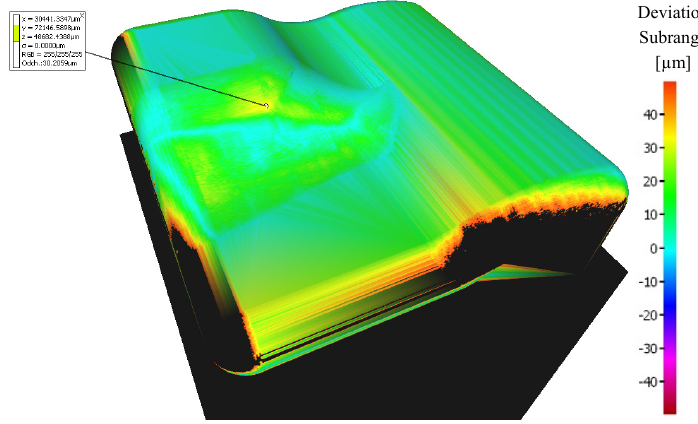
Figure 10. Comparison of the initial model with the workpiece after 3-axis milling (without tool axis inclination: β f = 0°, β n = 0°).